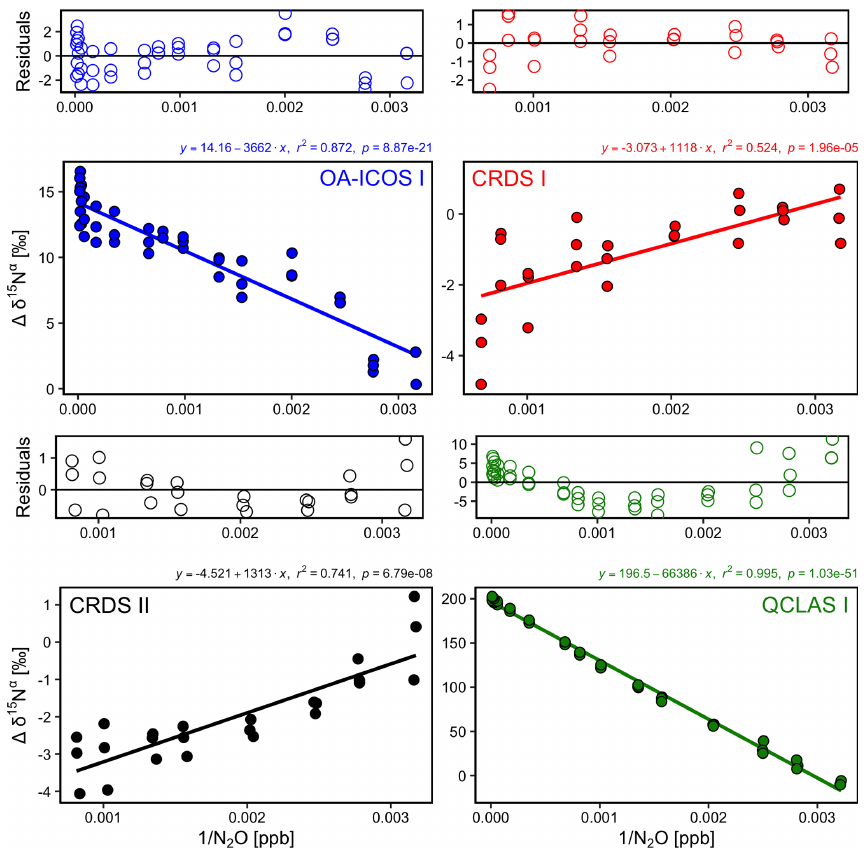
Figure 5. Deviations of the measured δ 15 N α , δ 15 N β and δ 18 O values according to 1 / [ N 2 O ] for the OA-ICOS I (blue), CRDS I (red), CRDS II (black) and QCLAS I (green). Measurements span the manufacturer-specified operational ranges of the analyzers. The experiment was repeated on three separate days. A linear regression is indicated by the solid line, and a residual plot is provided above each plot. Individual linear equations, coefficients of determination ( r 2 ) and p values are indicated above each plot. The remaining plots for δ 15 N β and δ 18 O are provided in Sect. S4 (Fig.